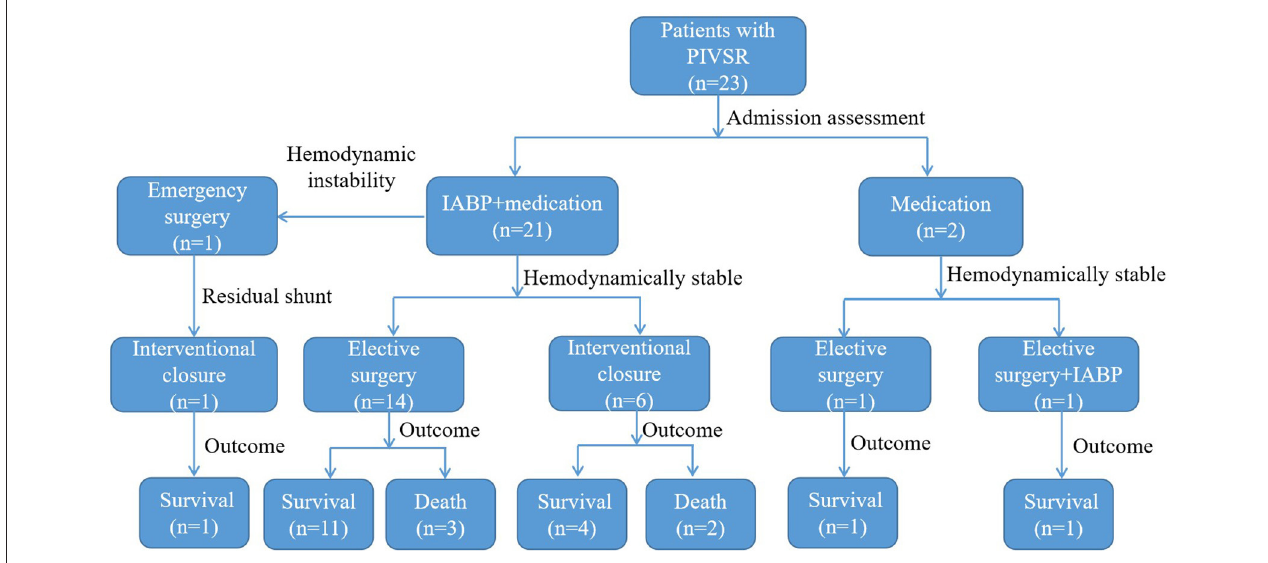
FIGURE 1 | The flow chart in the management and timing of postinfarction ventricular septal